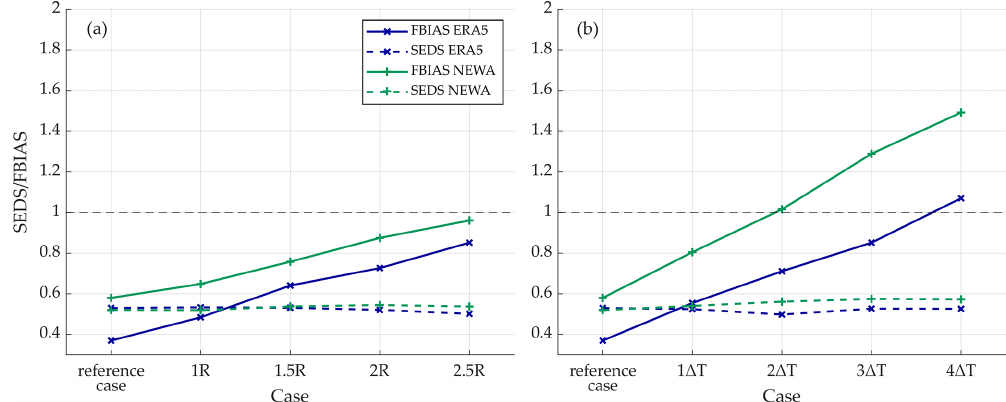
Figure 14. FBIAS and SEDS for ERA5 and NEWA considering different spatial (a) and temporal (b) thresholds. The spatial threshold R corresponds to 17 and 3km for ERA5 and NEWA, respectively. The temporal threshold (cid:49)T corresponds to 1 and 0.5h for ERA5 and NEWA,